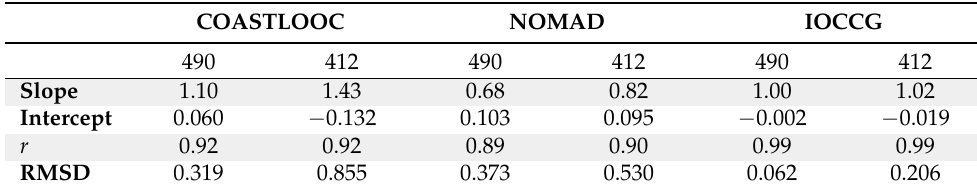
Figure A1. Results retrieved from the COASTLOOC the NOMAD & IOCCG synthetic dataset at 412 nm and 490 nm: ( a ) scatterplot of estimated versus desired K d ( λ ) values for the COASTLOOC dataset; the dashed line is the 1:1 line; ( b ) ratio of the estimated versus desired K d ( λ ) ; the horizontal line is a ratio of 1; ( c ) scatterplot of estimated versus desired K d ( λ ) values; the dashed line is the 1:1 line; ( d ) ratio of the estimated versus desired K d ( λ ) ; the horizontal line is a ratio of 1. Table A3. Summary statistics for the retrieval of K d ( 490 ) and K d ( 412 ) from Jamet’s neural network algorithm using NOMAD & IOCCG initial dataset and the validation dataset of COASTLOOC. Root Mean Square Difference (RMSD) is the square root of the mean square error between the retrieved K d and the measured/simulated K d ; r is Pearson’s correlation